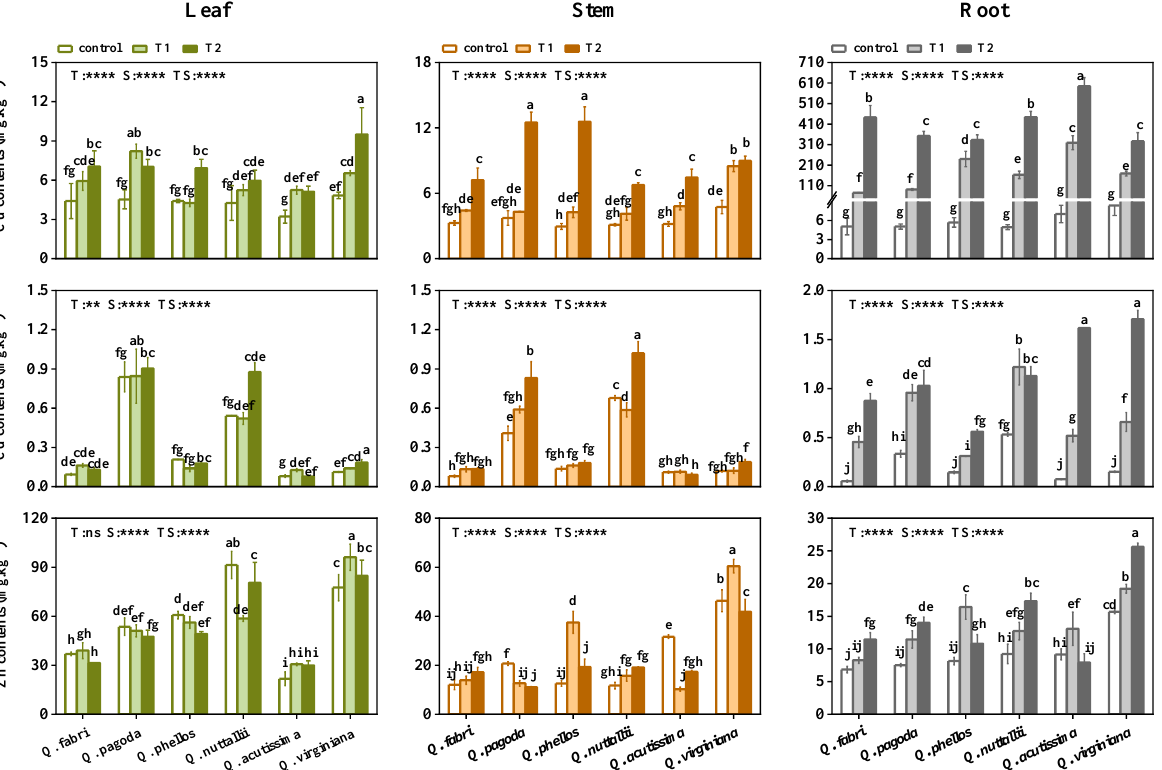
Figure 3. Metal accumulation of six Quercus species cultivated in control, T1 (mixture of clean and polluted soil, 50%), and T2 (100% polluted soil) treatments for 150 d. Data represent the mean of three replicates ± SD ( n = 3). p values of the two-way ANOVAs of soil treatments (T), Quercus species (S), and their interactions (T × S) were also shown. ns, not significant; **, p ≤ 0.05; ****, p ≤ 0.0001. The different letters showed the significance at level of 0.05.